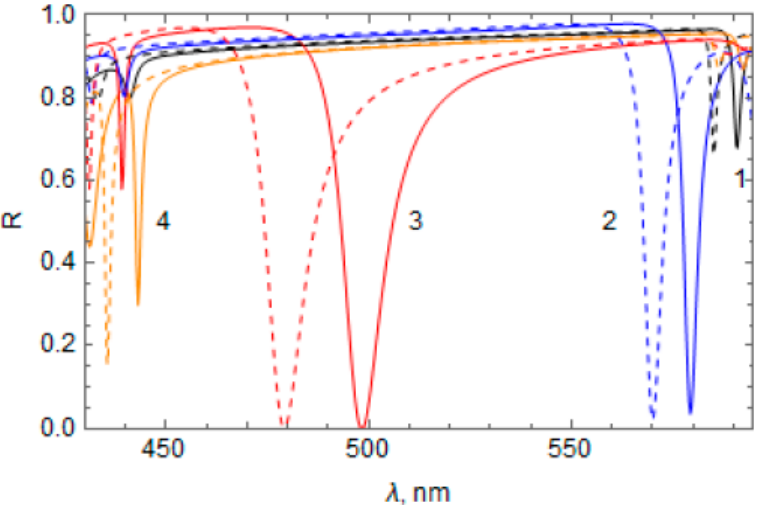
Figure 7. Comparison of the reflectance spectrum of the “Ag layer + RF” calculated using COMSOL software (solid lines) and using Equations (12)–(15) (dashed lines) at n p = 0.5 TPP bands are numbered according to Table 1: 1 (black), 2 (blue), 3 (red), 4 (orange). n = 1.85, a = 137.1 nm, thickness of the Ag layer = 45